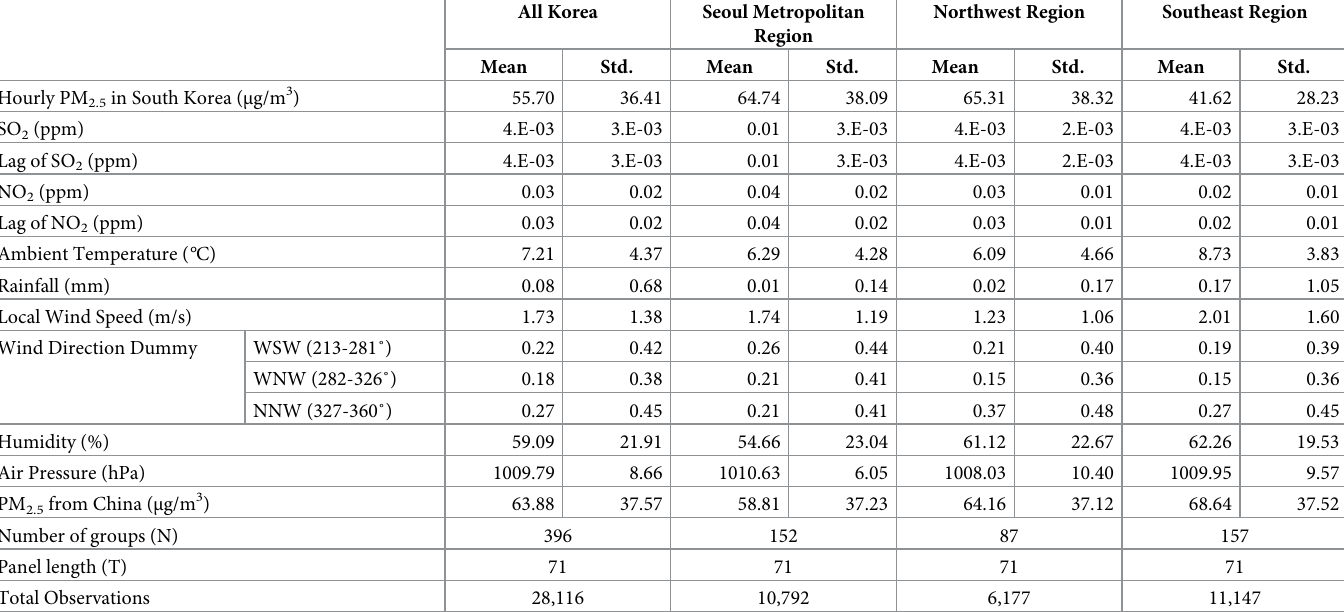
Table 1. Descriptive statistics for the variables used in the spatial panel-data model.